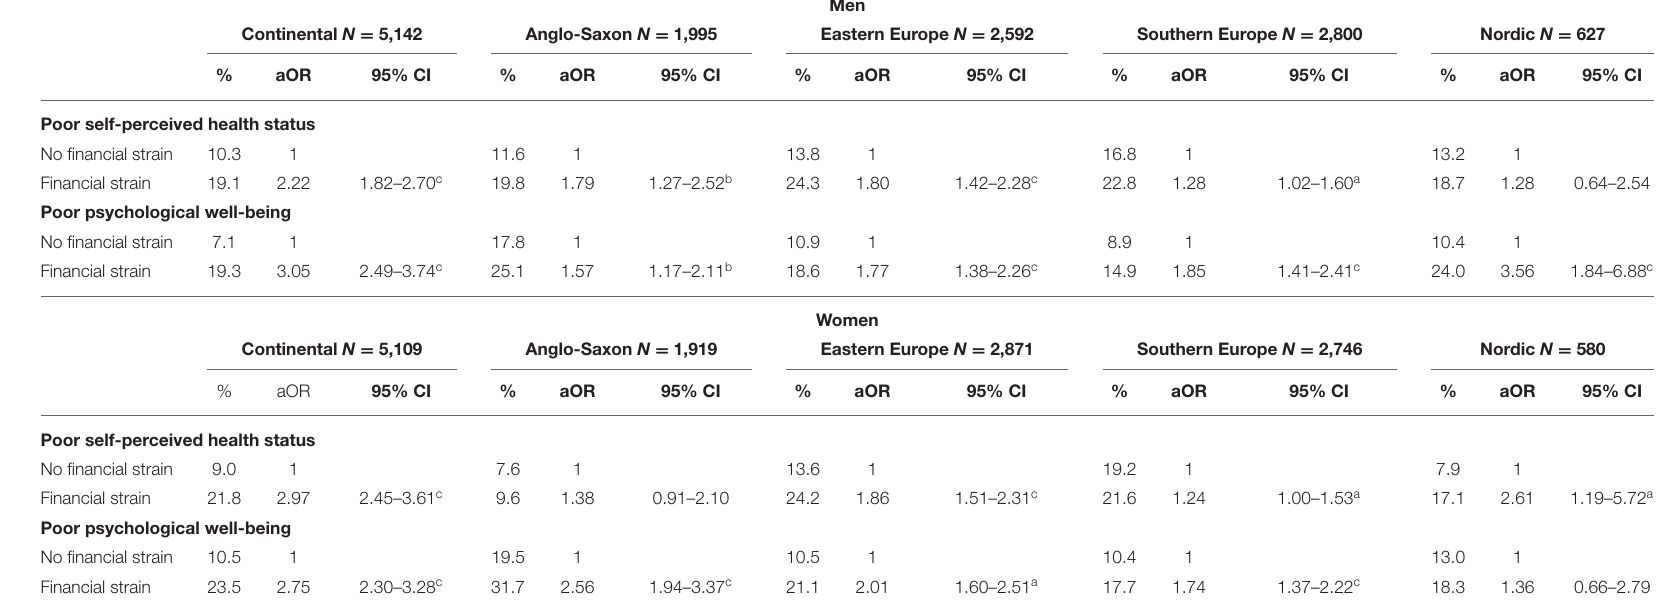
TABLE 3 | Association between family financial strain and health by welfare state typology and gender.